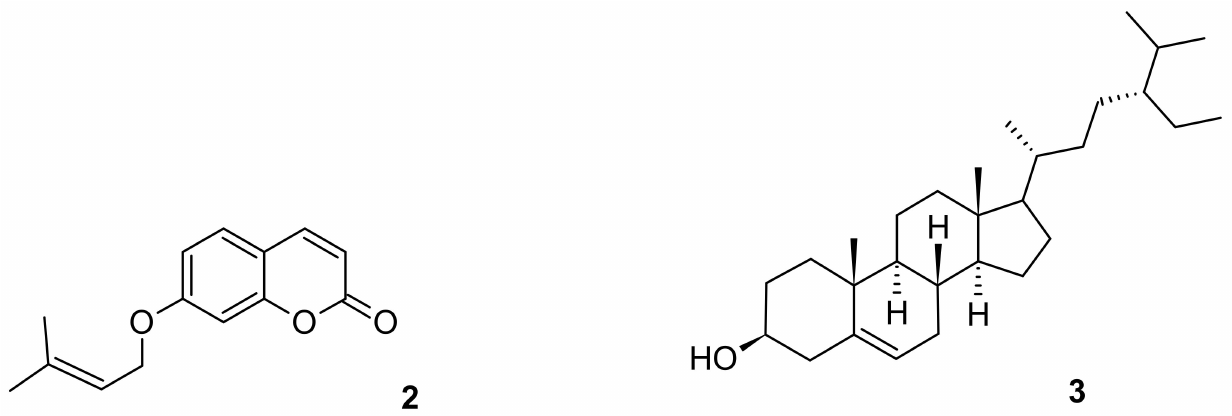
Figure 3. Chemical structures of compounds 2 and 3